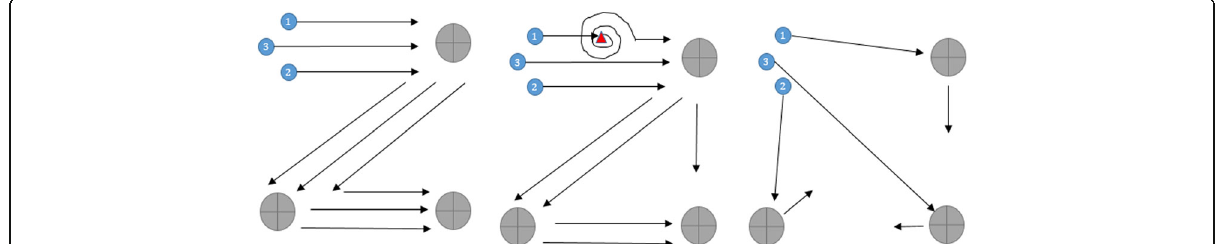
Fig. 1 UAV search methods. Actual patterns are more complex; the patterns depicted here are simplified for clarity. Blue dots are UAVs, gray areas are destination targets, and red triangle is a concentration of survivors. From left to right: standard, spiral, and